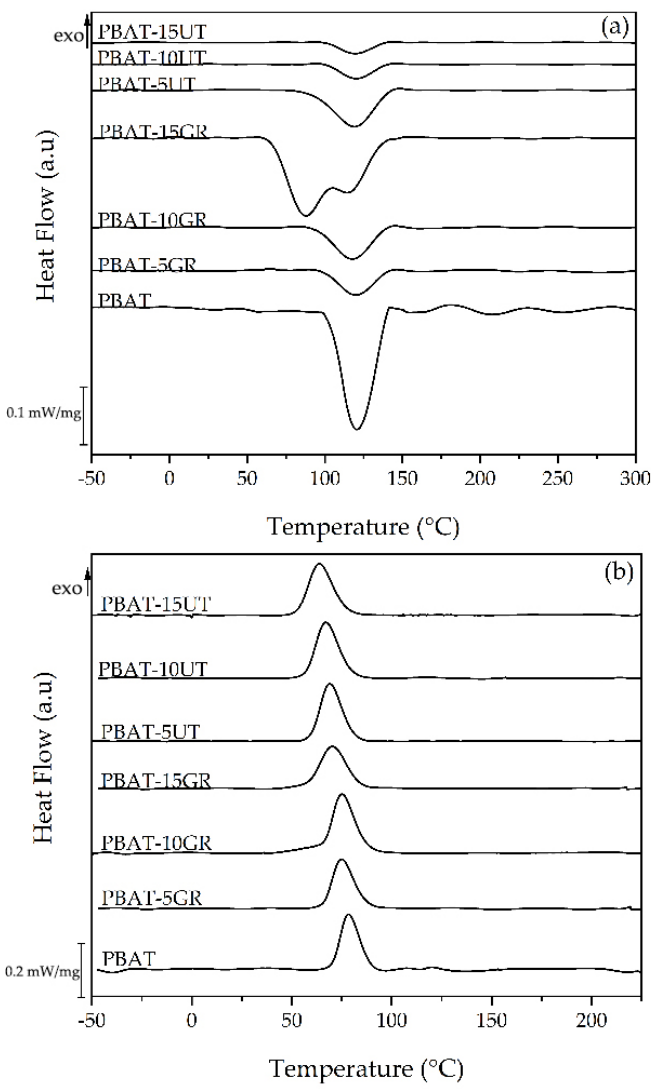
Figure 3. Differential scanning calorimetry ( a ) second heating scan and ( b ) cooling curves for PBAT and PBAT resin-based formulations.